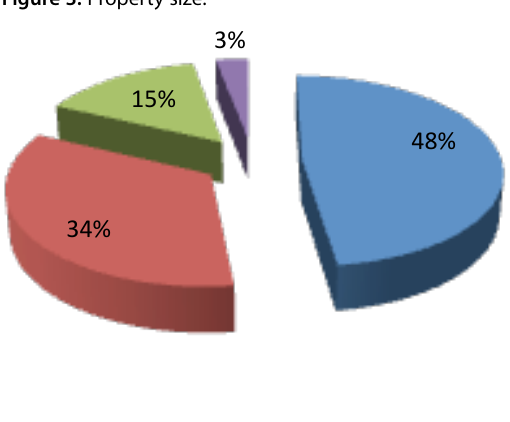
Figure 3. Property size.